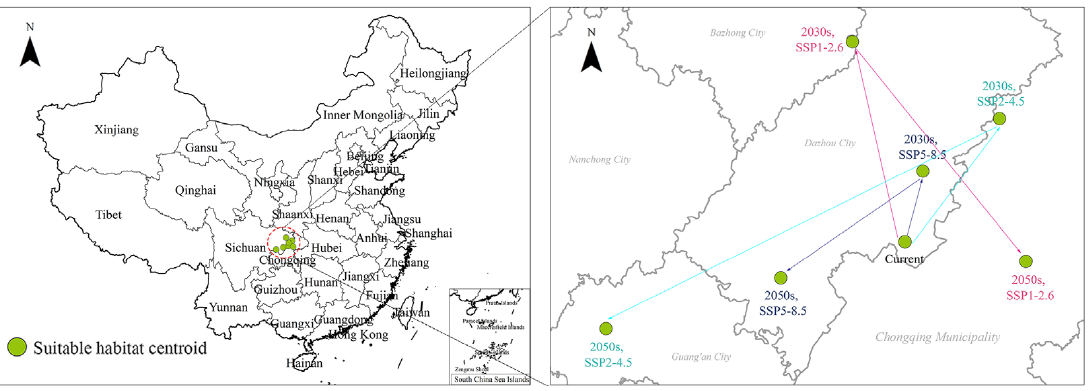
Figure 8. Changes in the centroid distributional shifts of Tagetes minuta under climate change.